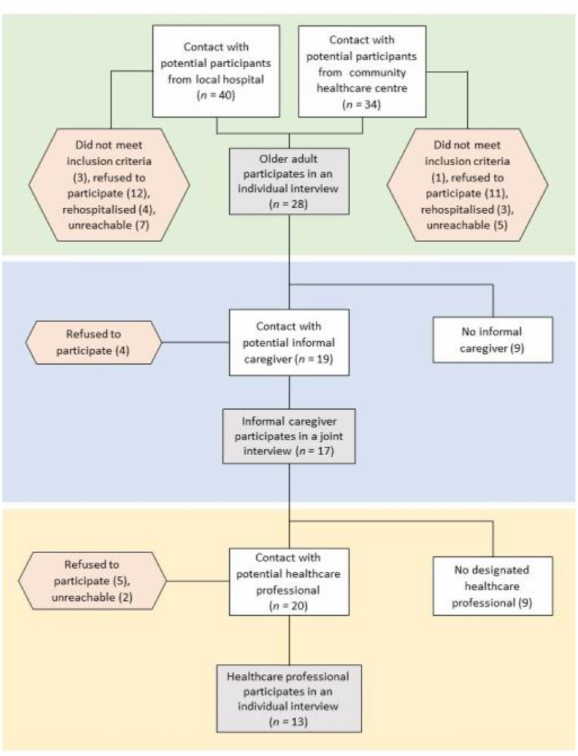
Figure 2. Description of the enrolment